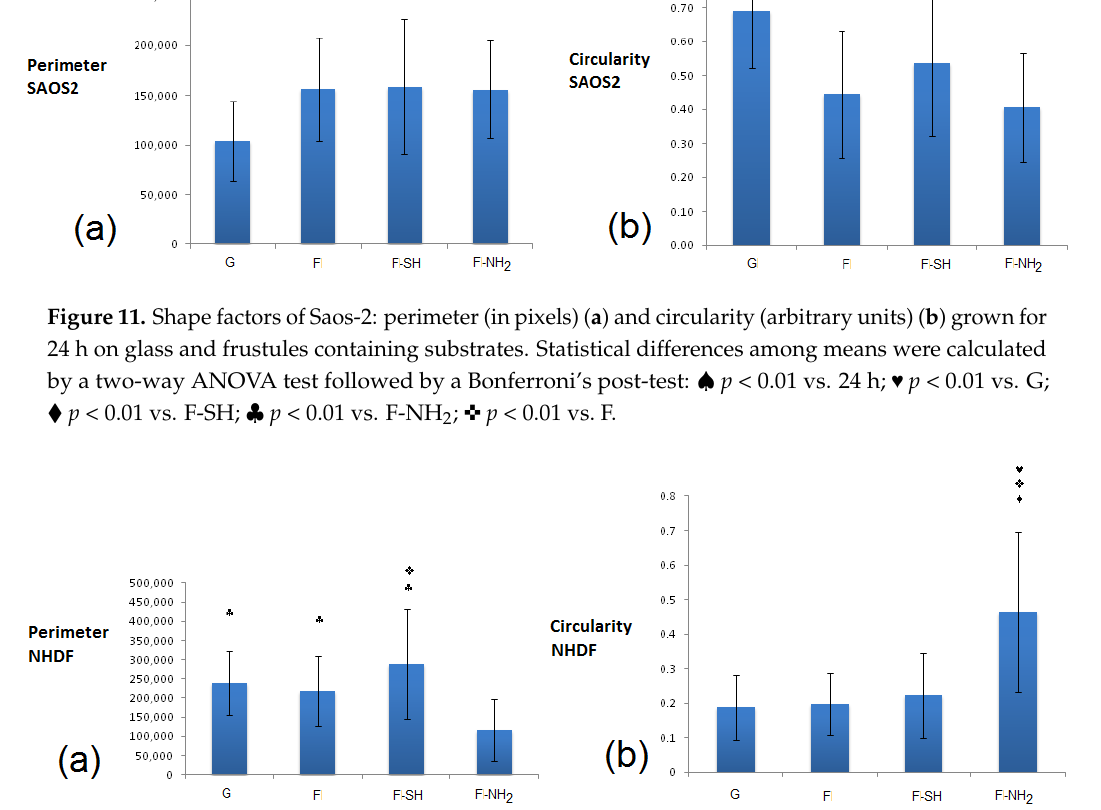
Figure 12. Shape factors of NHDF: perimeter (in pixels) ( a ) and circularity (arbitrary units) ( b ) grown for 24 h on glass and frustules containing substrates. Statistical differences among means were calculated by a two-way ANOVA test followed by a Bonferroni’s post-test: ♠ p < 0.01 vs 24h; ♥ p < 0.01 vs G; ♦ p < 0.01 vs F-SH; ♣ p < 0.01 vs F-NH 2 ; ✜ p < 0.01 vs F.